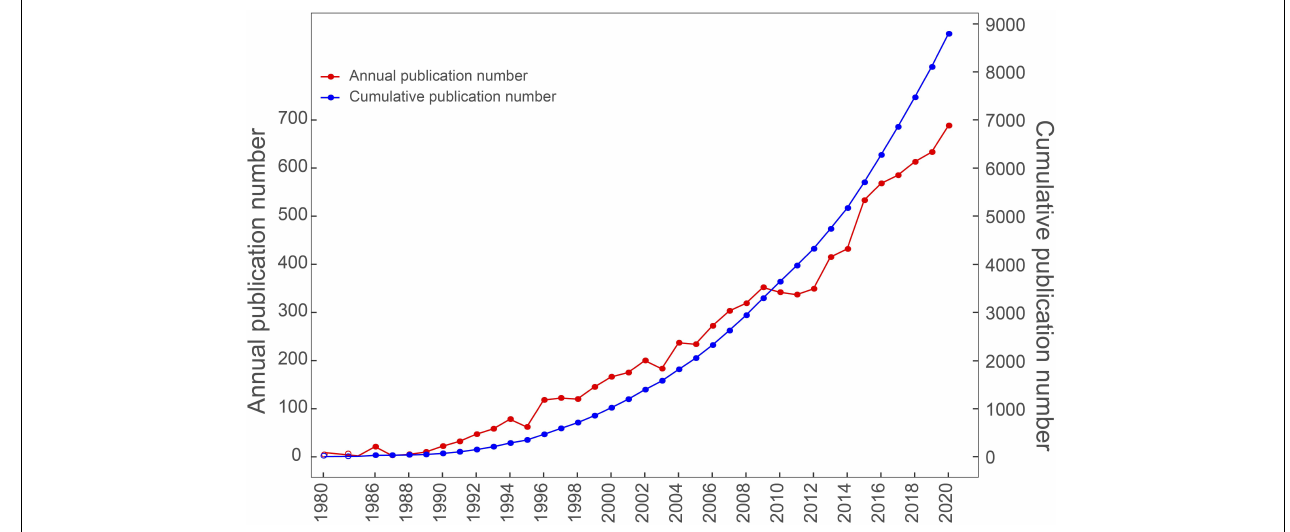
FIGURE 1 | The pattern of the annual and cumulative number of publications in the period from 1980 to 2020.